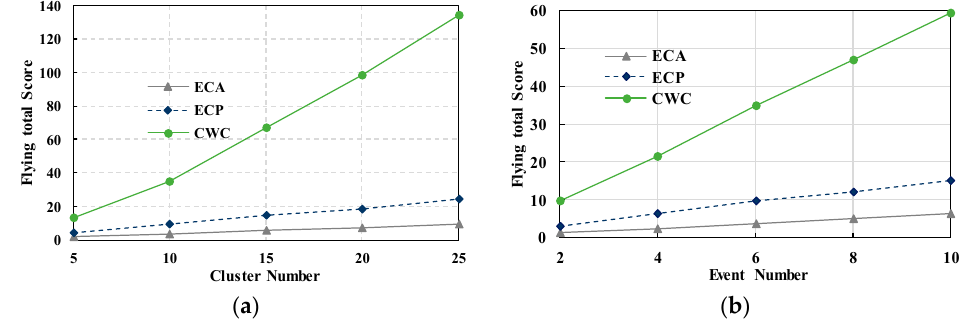
Figure 5. Comparison of Total Flying Scores. ( a ) Flying Scores in different cluster number; ( b ) Flying Scores in different event number.